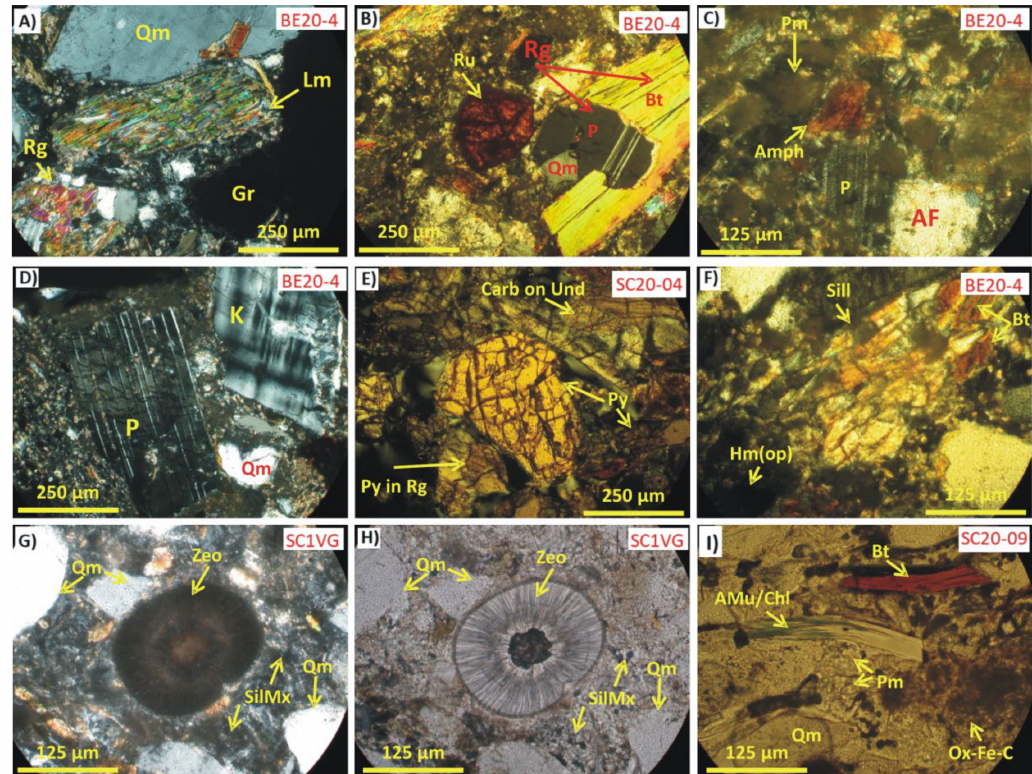
Figure 7. Photomicrographs from petrographic thin sections illustrating diagnostic grains of Santa Caterina (SC) and Belmonte (BE) outcrops. ( A ) Metamorphic fragments (Lm) with lepidoblastic texture. Rg: phaneritic granitic/gneissic rock fragment. Monocrystalline quartz (Qm) and garnet (Gr). ( B ) Coarse-grained granitic/gneissic rock fragments (Rg) including biotite (Bt), plagioclase and quartz (Qm). Ru: sub-rounded single crystal of rutile. ( C ) Cineritic layer with pumice grain (Pm), monocrystalline plagioclase (P) and brown amphibole (Amph). AF: Sericite replacement on undetermined feldspar. ( D ) P: single crystal of plagioclase supplied by granitic/gneissic source rocks. K: single crystal of K-feldspar (microcline). Qm: monocrystalline quartz. ( E ) Abundant monomineralic grains of pyroxene (Py) and few pyroxene in granitic/gneissic rock fragments (Py in in Rg). Carb on und: carbonate replacement on undetermined grain. ( F ) Sill: Sillimanite (fibrolite variety). Hm(op): opaque heavy mineral. Bt: Biotite. ( G , H ) Fan-shaped fibrous zeolite (Zeo). SilMx: siliciclastic matrix. Qm: monocrystalline quartz. ( I ) Biotite (Bt) and muscovite (Mu) flakes. AMu/Chl: chlorite replacement on muscovite. Qm: monocrystalline quartz. OX-Fe-C: Oxid-Fe cement. Pm: pumice. ( A – G ) are crossed-nicols photomicrographs; ( H , I ) are plane-polarized-light